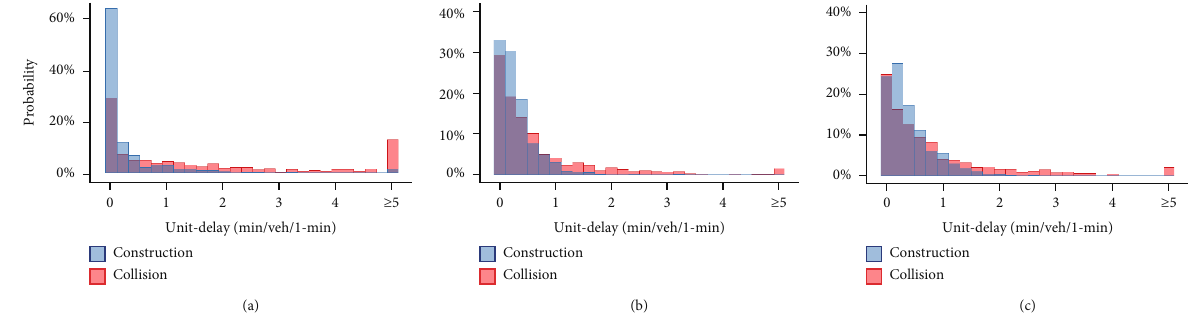
Figure 13: Histograms of unit-delays by event type for (a) main facility, (b) minor facility within a 2-mile radius, and (c) minor facility within a 3-mile radius bin width = 0 : 2 . Table 12: Collision and improvement actions unit delay models: coe ffi cients from estimated tobit regression analysis (minutes/vehicle/1- minute event